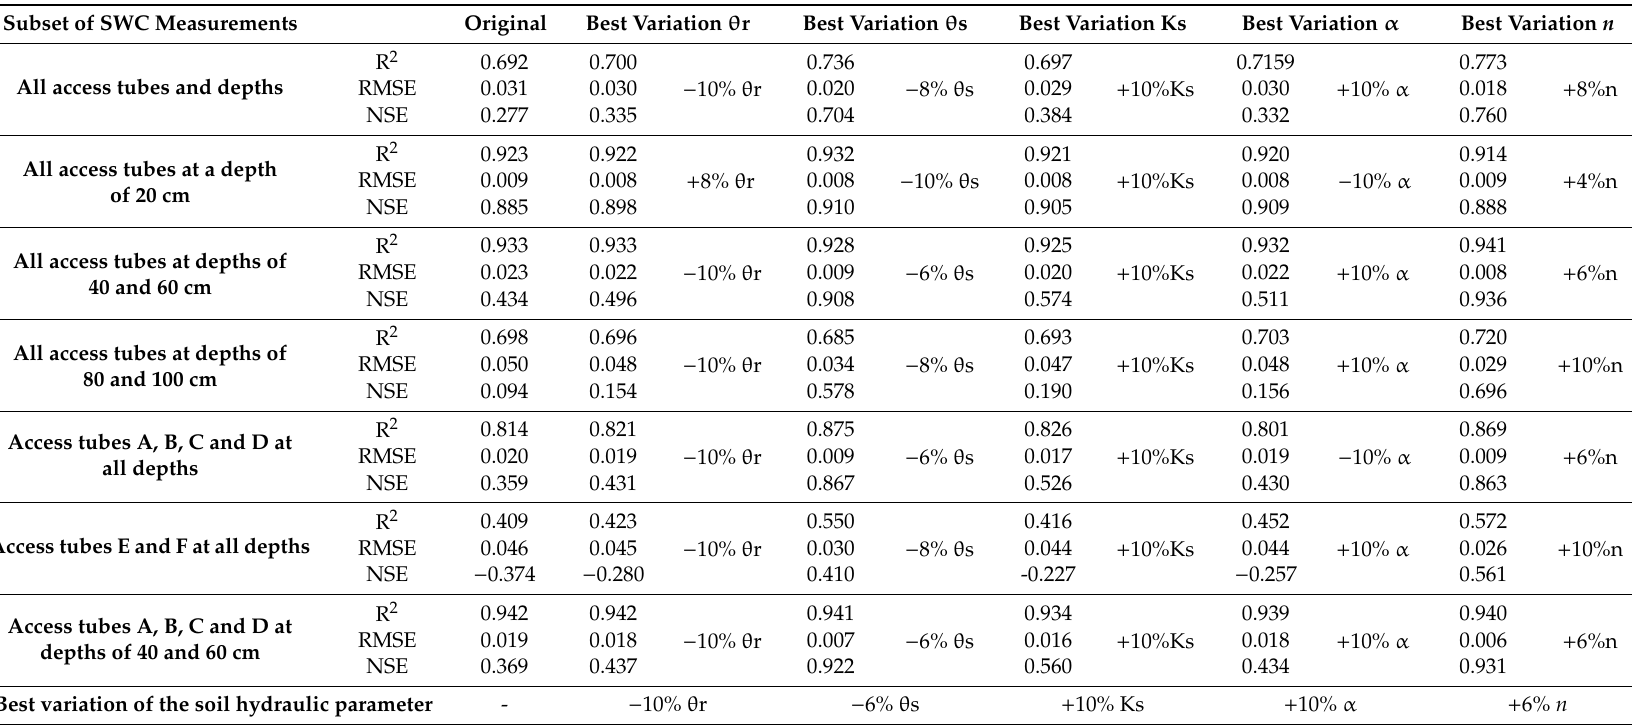
Table 6. Variations in the fit between simulations parameterized from HYPROP + WP4C and measurements of SWC (cm 3 cm − 3 ) by neutron probe, when each soil hydraulic parameter was varied between − 10% to + 10% around the original value. The average measurements were obtained on 8 di ff erent dates in the 2018 irrigation